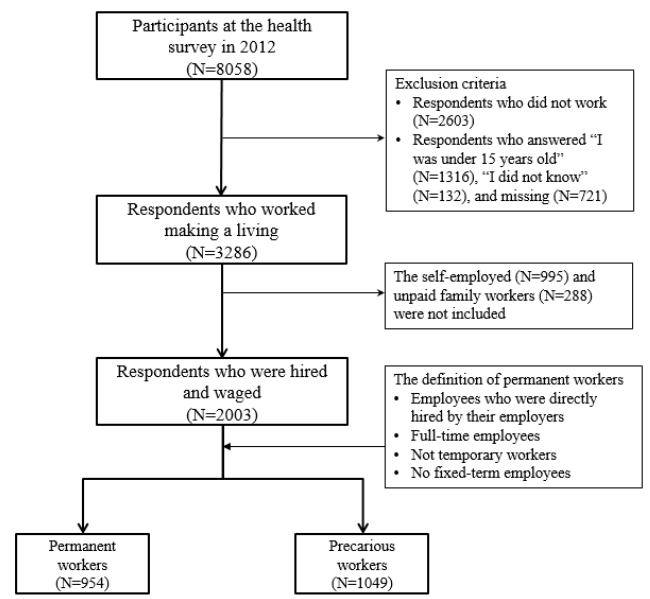
Figure 1. Selection of study subjects from the Korea National Health and Nutrition Examination Survey (KNHANES).